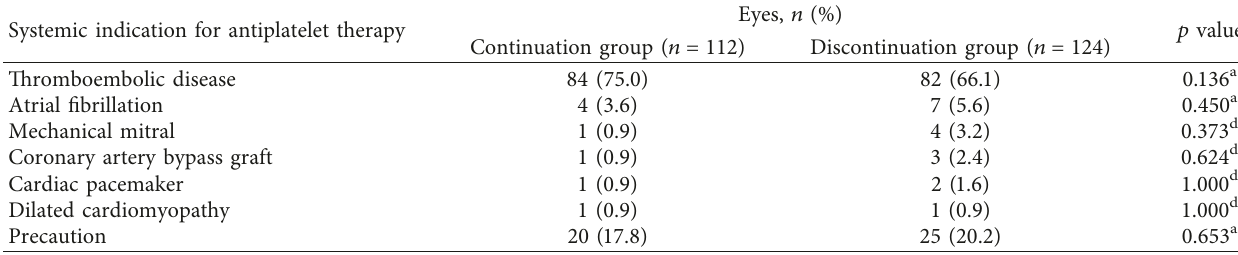
Table 2: Systemic indication for antiplatelet therapy.